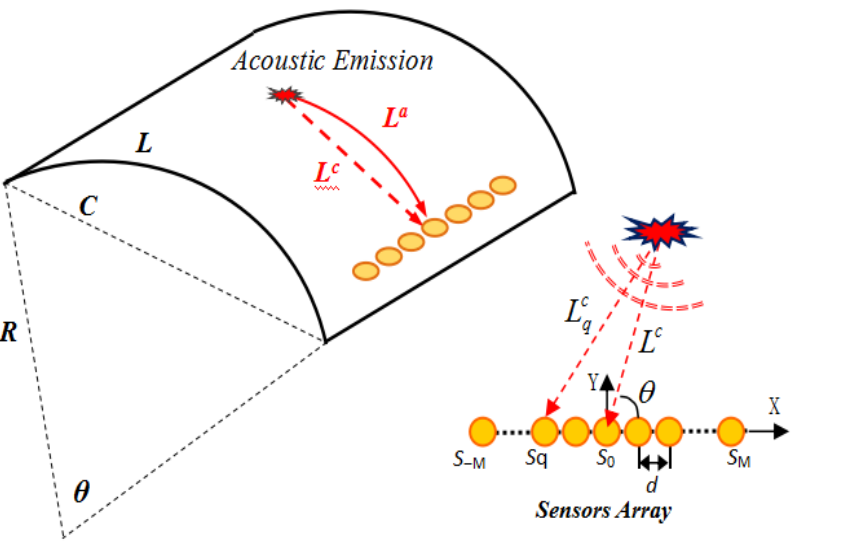
Figure 1. Acoustic emission signal model of a curved panel.